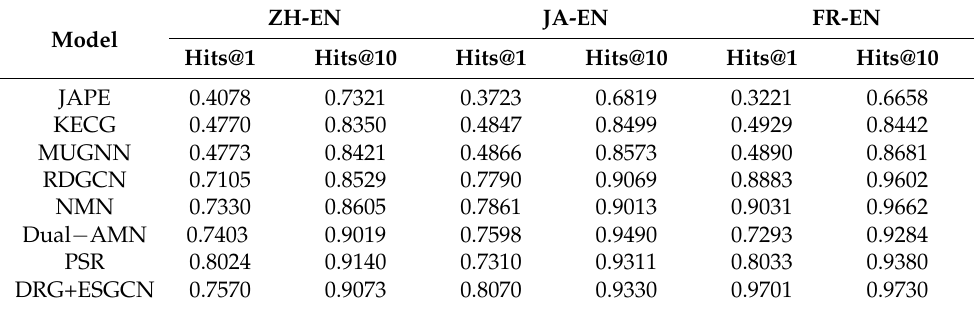
Table 2. Performance on DBP15K dataset.